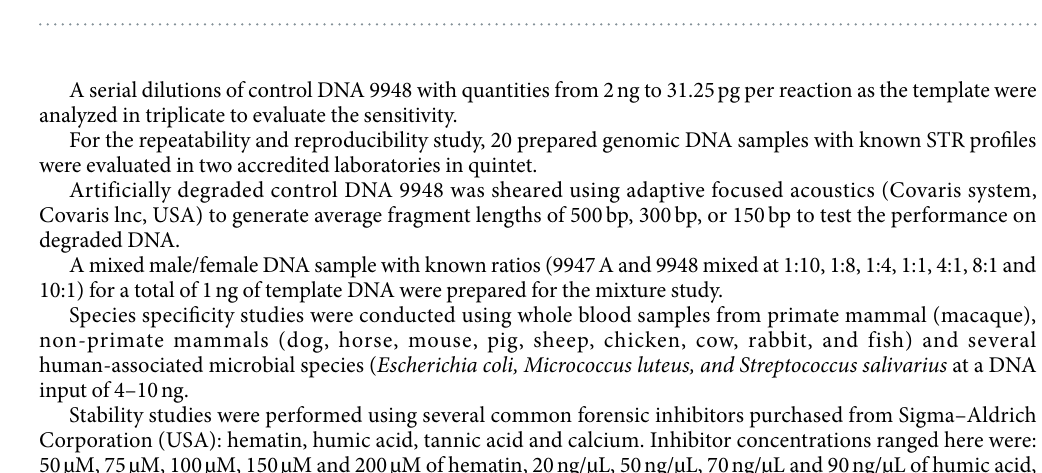
Tablee 1. General information of 27